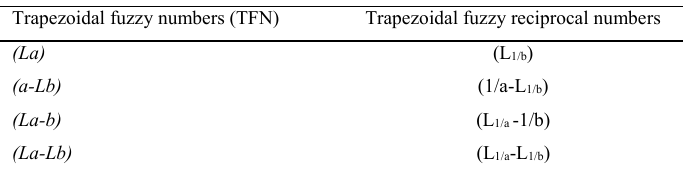
Table 2: Trapezoidal fuzzy numbers of linguistic variables Trapezoidal fuzzy numbers (TFN)